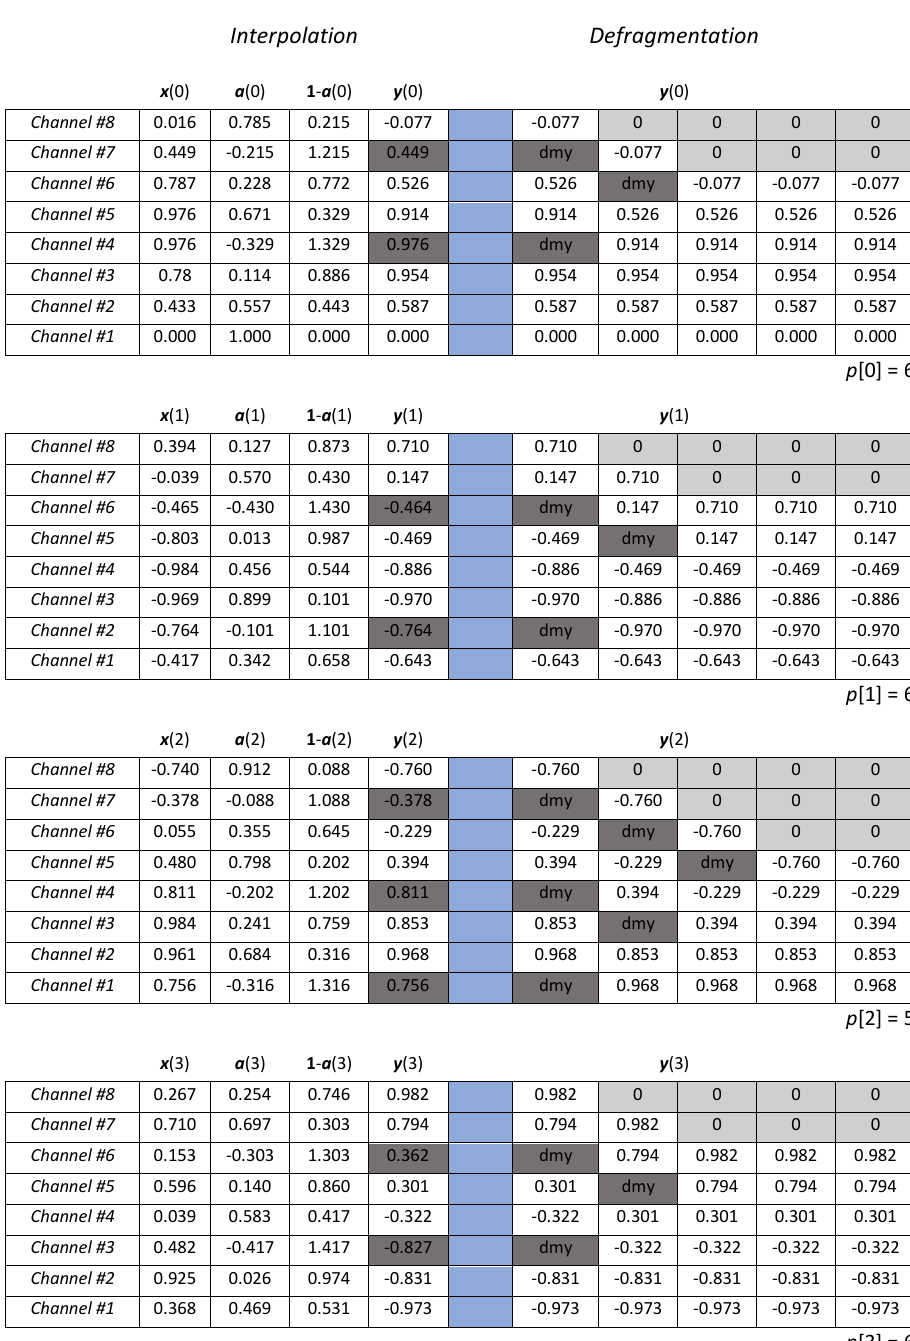
Figure 8. The multi-channel system acquires 8-size arrays, x , that are processed to gain the re-sampled values, y . Sampled and resampled values are enlisted from bottom to top in their columns; two additional columns show the coefficient arrays adopted to perform the interpolation. All the steps needed to attain the defragmentation of the re-sampled data are detailed on the right